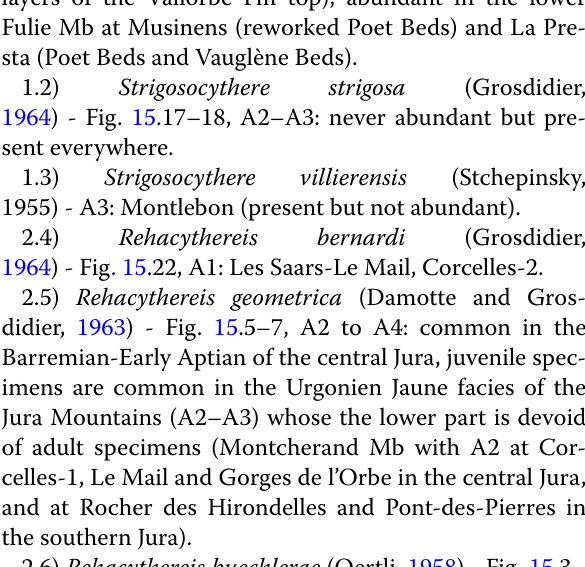
sp. - Fig. 15.9–12, A2 to A4 (incl. Poet Beds): common everywhere. The basal Falaises Mb (A1) has provided some small-sized specimens of B. aff. barremiana , maybe juveniles as in A2, but there is no available comparison with other sites of the Falaises Mb to be sure of this spe- cific